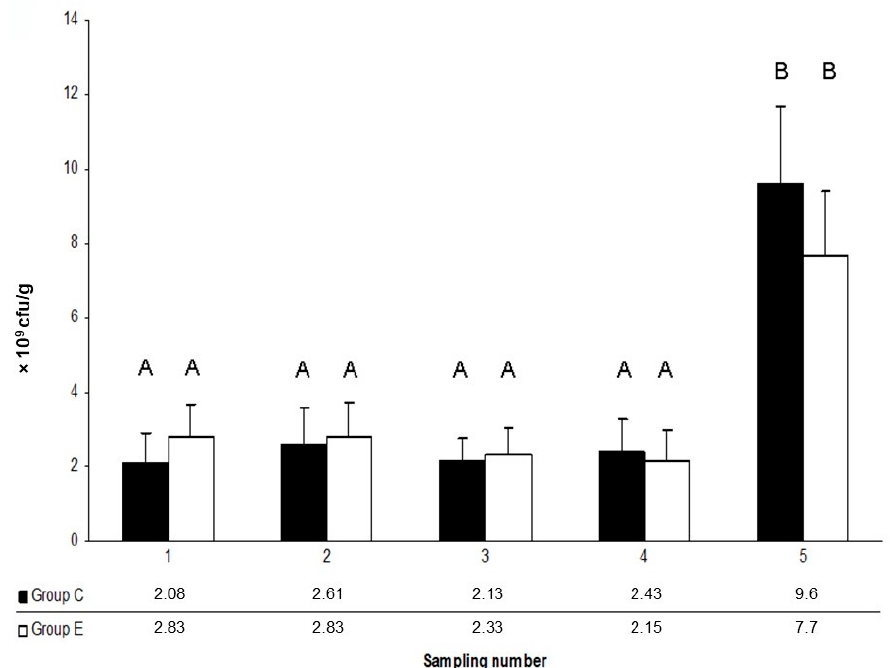
Figure 1. Changes in mesophilic microbial number during the experiment ( p -value ≤ 0.05). Bars with different letters represent samples collected at 20-day intervals (number of measurments n = 5; 1—2 January, 2—22 January, 3—11 February, 4—3 March and 5—21 March). Group C—control group, group E—experimental group. Letters A and B above the bars are significantly different at p -value ≤ 0.05.